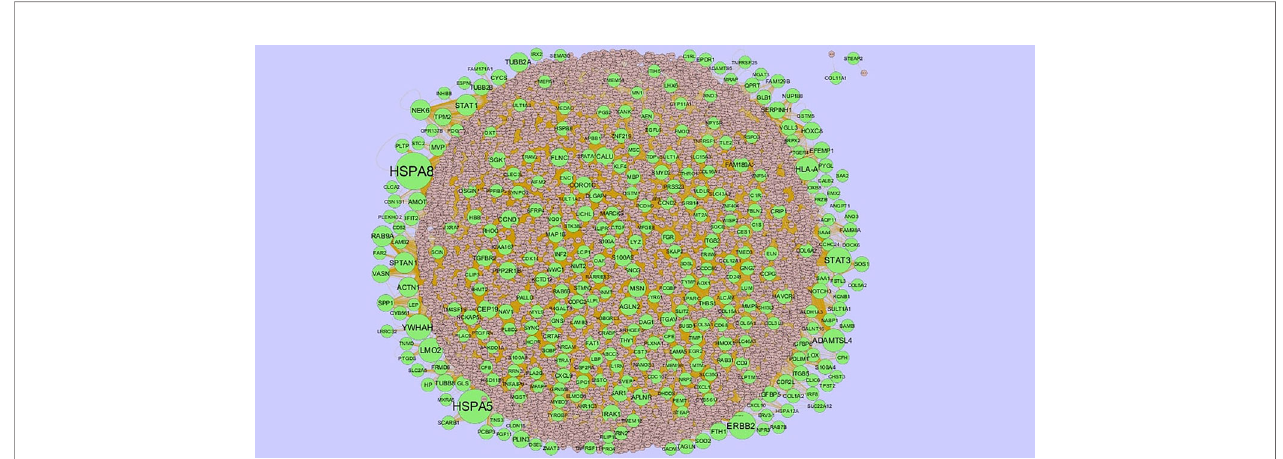
FIGURE 4 | Protein – protein interaction network of up regulated genes. Green nodes denotes up regulated genes.